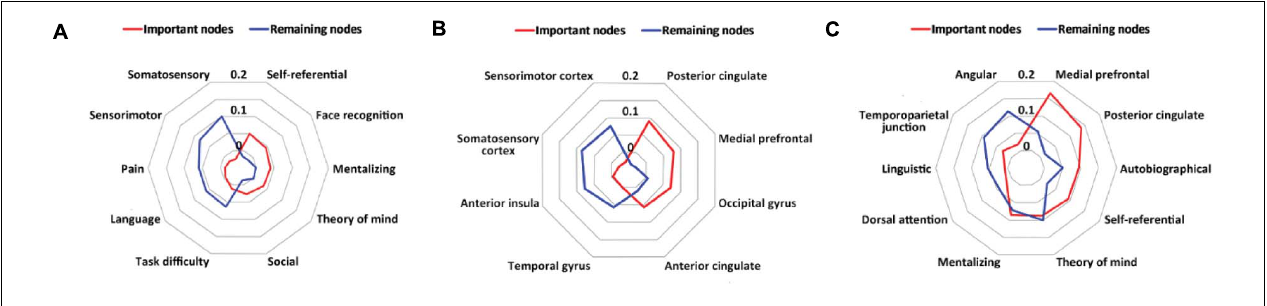
FIGURE 4 | Results of meta-analytic decoding. (A) The psychological constructs related to the important nodes (red) and the remaining nodes (blue) in the whole-brain prediction. (B) The brain structures related to the important nodes (red) and the remaining nodes (blue) in the whole-brain prediction. (C) The psychological constructs and brain structures related to the important nodes (red) and the remaining nodes (blue) in the default mode network-based prediction.